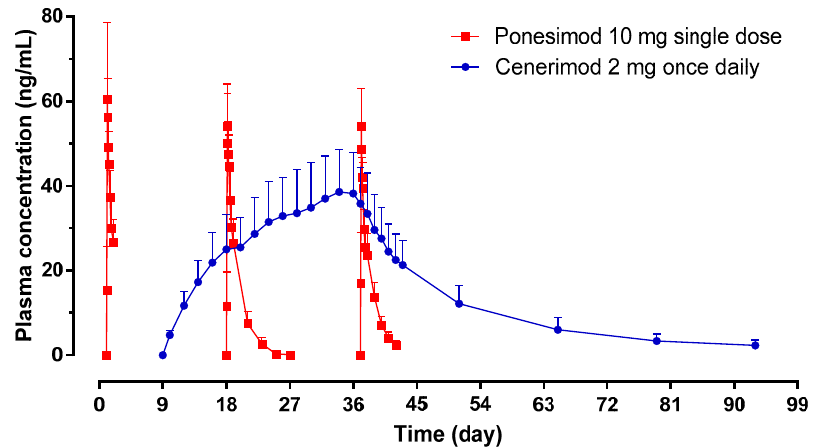
Figure 3. Plasma concentration–time profiles of cenerimod and ponesimod. Arithmetic mean plasma concentration–time profiles of ponesimod (red curves) and trough concentration of cenerimod (blue curve) ( n = 8). Error bars represent standard deviations.